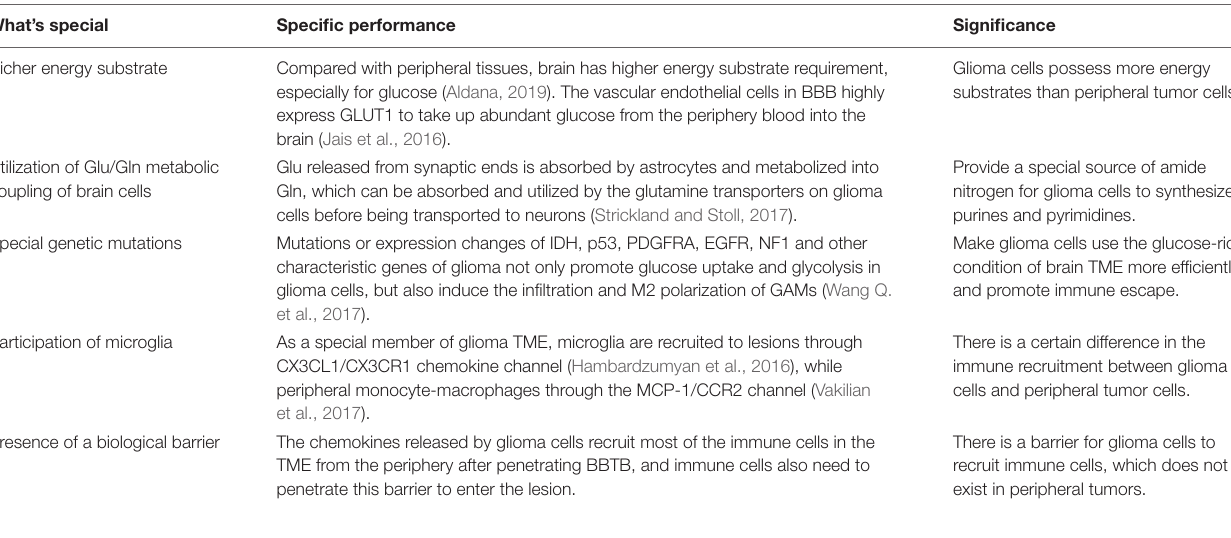
TABLE 3 | Differentials in cell metabolism and immune TME of gliomas compared with peripheral